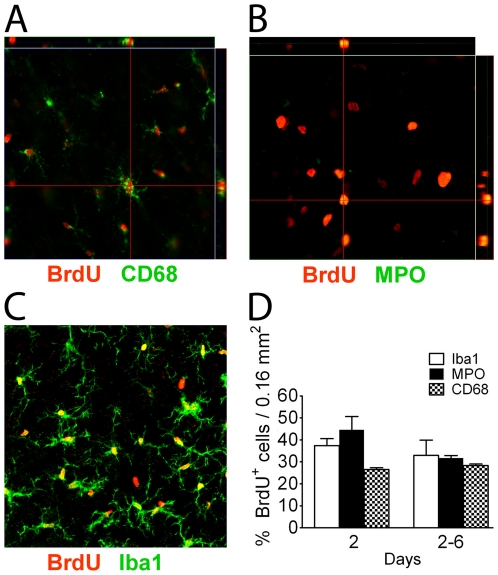
Analysis of proliferating cells in the penumbra identifies many inflammatory cells.Using different antibodies to identify the cell types labelled with BrdU, reveals that most proliferating cells are microglia/macrophages (A, C) and monocytes/neutrophils by colocalization (B) of cell type markers with BrdU, and this was confirmed by the morphometric analysis (D). N = 3 animals for day 2, N = 5 animals for day 7. Scale Bar, 50 µm.